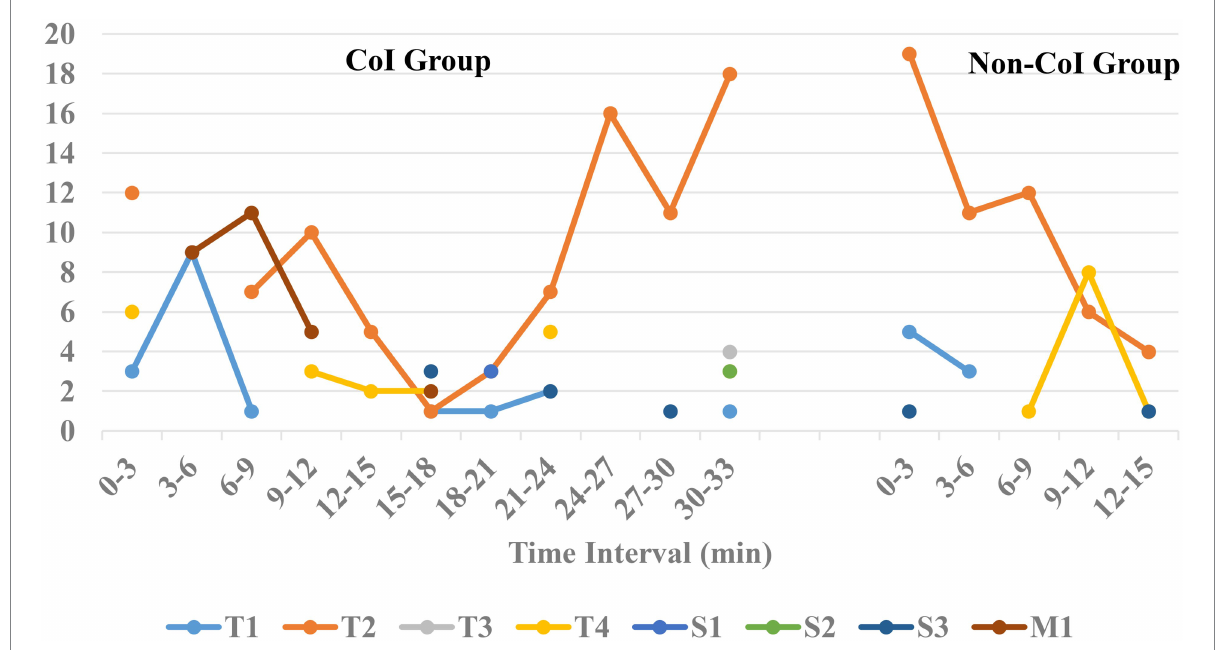
FIGURE 7 Time trends showing STEM competencies in discourse across a CoI and Non-CoI group. T1 = investigating and defining, T2 = generating and designing, T3 = producing and implementing, T4 = evaluating, S1 = science understanding, S2 = science social/ethical, S3 = science inquiry skills, M1 = mathematical